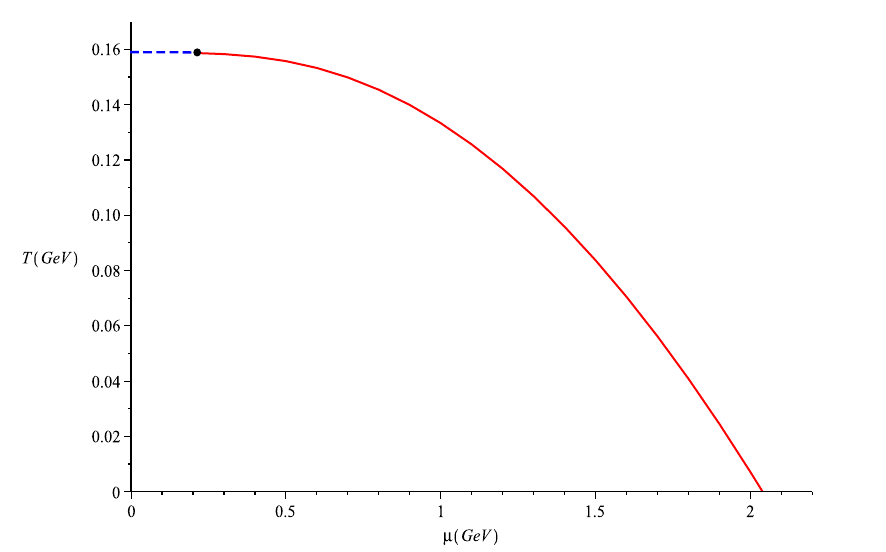
Figure 8 . The phase diagram of χ SB , in which the second order phase transition point is identified as the CEP of the phase